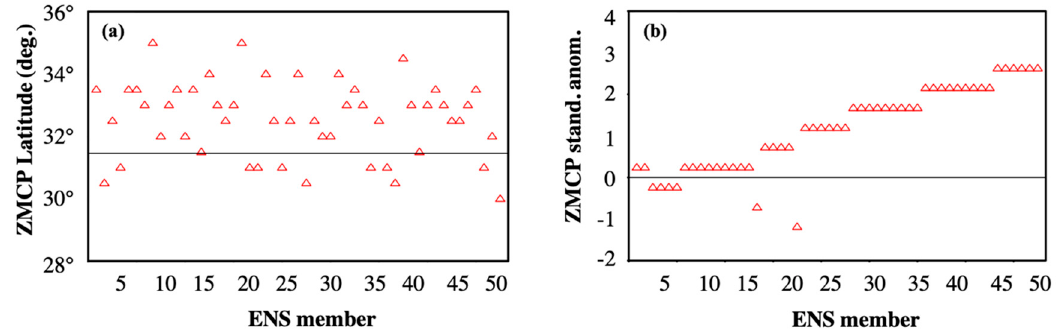
Figure 7. The ZMCP of the event total (120-h) accumulated precipitation for the observed total accumulated precipitation from daily rain gauge data interpolated to a 0.5° × 0.5° gridded domain (black line) and each Ensemble Prediction System (EPS) member (red triangles) from the ECMWF ensemble initialized at 1200 UTC 29 June 2016. ( a ) The forecasted ZMCP latitude for each EPS member and observed ZMCP. ( b ) ZMCP standardized anomaly for each forecasted EPS member, re-ordered by the magnitude of the anomaly from the observed mean rain belt position. The standardized anomaly represents the standard deviation of each ensemble member rain belt position index (RBI) from the observed RBI, standardized by the ensemble mean.